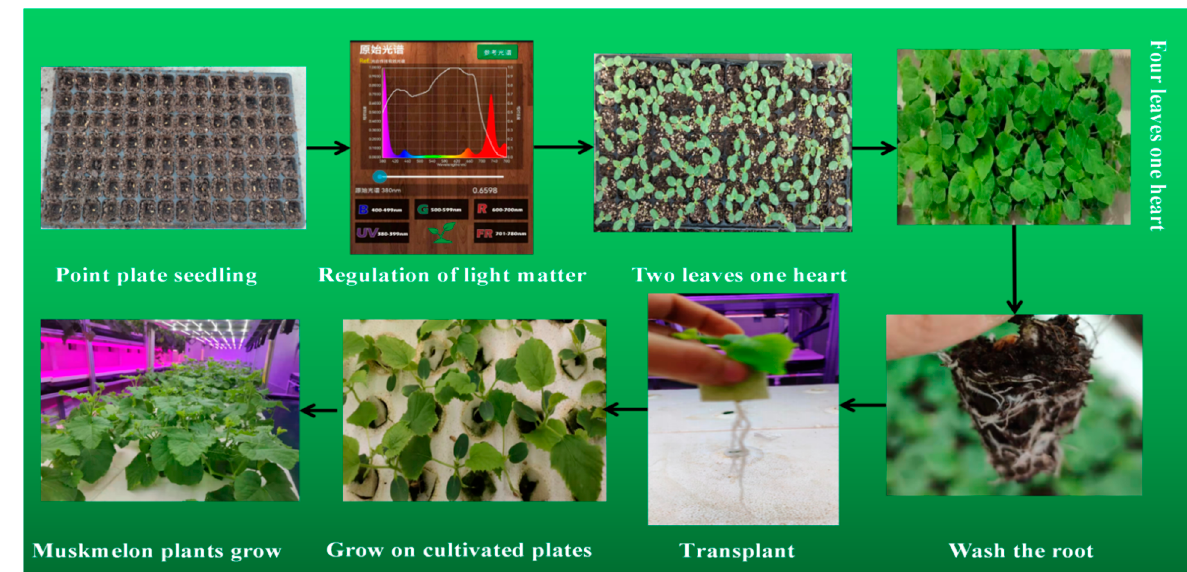
Figure 1. Flow diagram of muskmelon planting in the plant factory. Table 1. Design of muskmelon growth and development. R/B/W represents red light, blue light, and white light.